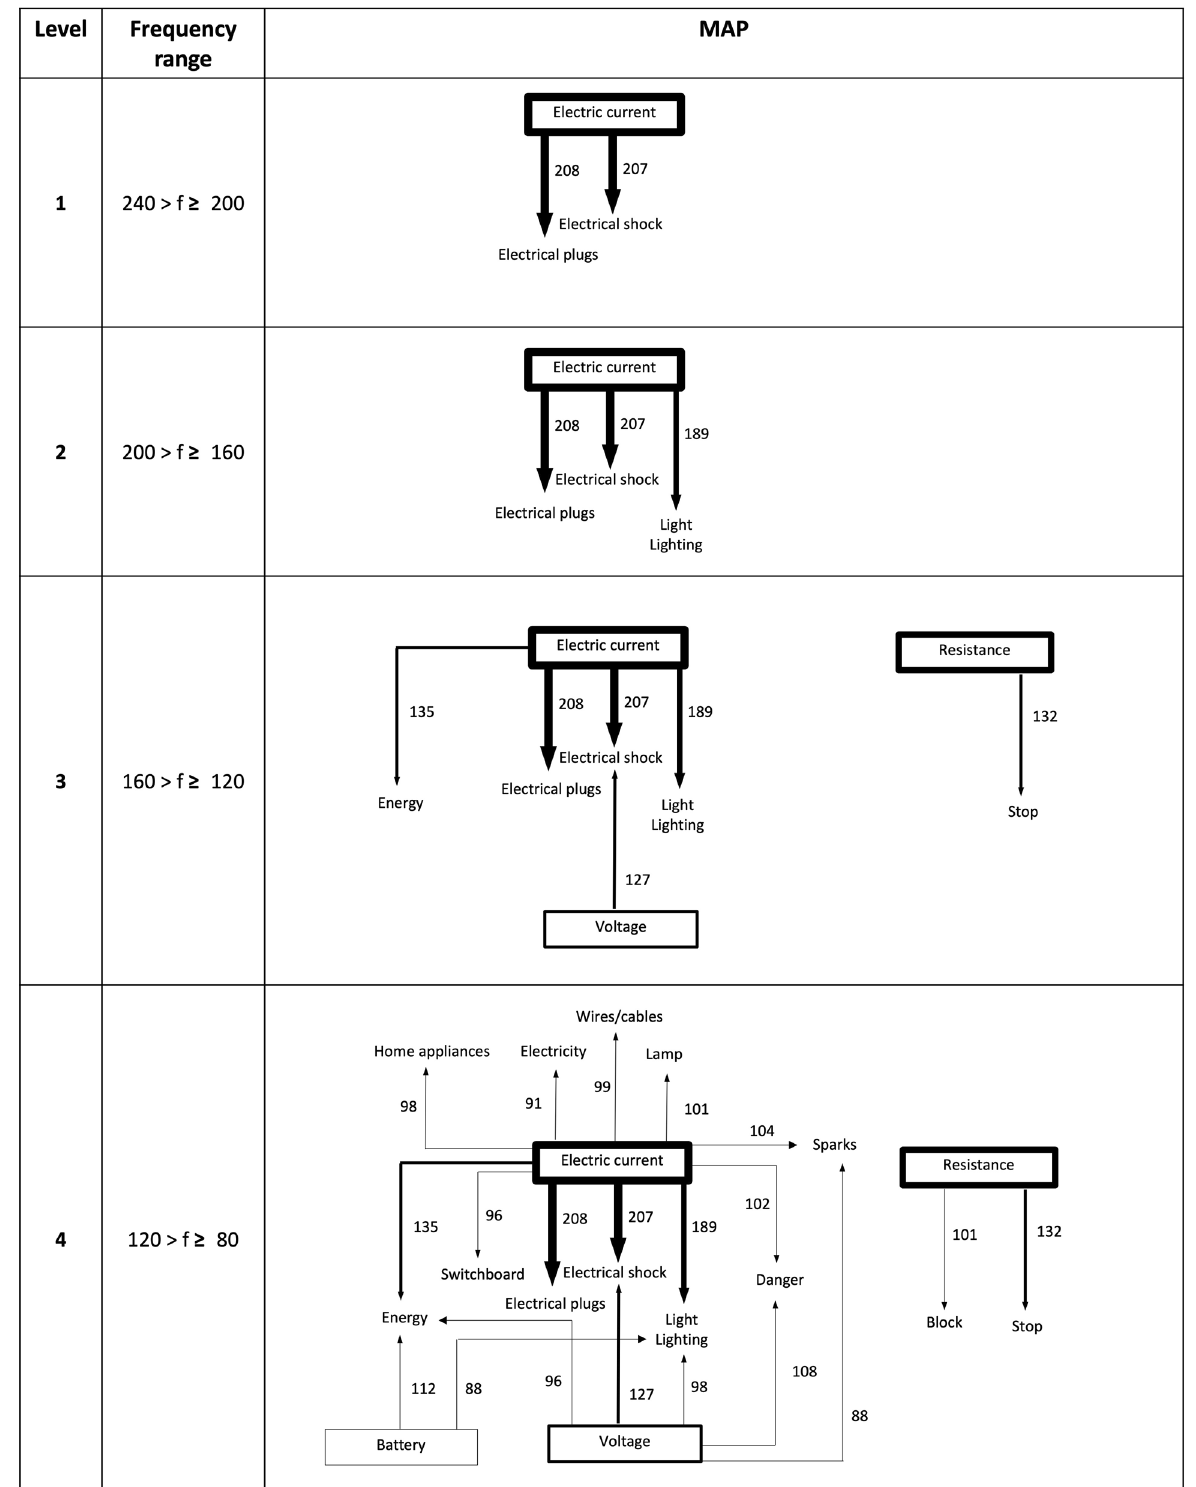
Fig. 1 Map of students’ cognitive structures at M1 (control